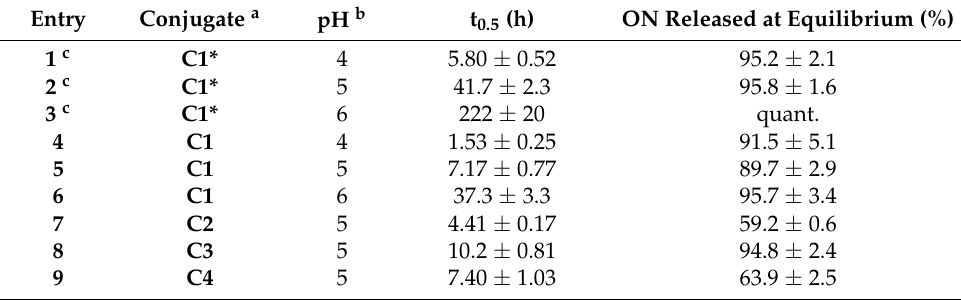
Table 1. Hydrolysis rates of the U NOMe conjugates at 37 ◦ C.